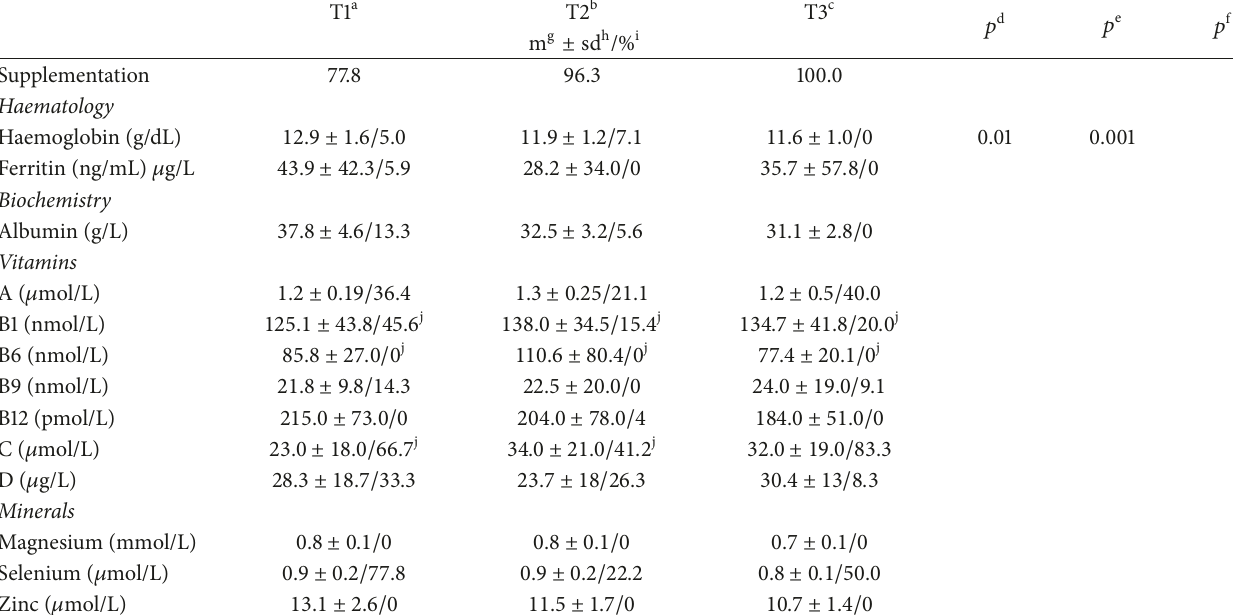
Table 4: Mean values of parameters and prevalence of maternal nutritional deficiencies during pregnancy ( 𝑁 = 57 ).